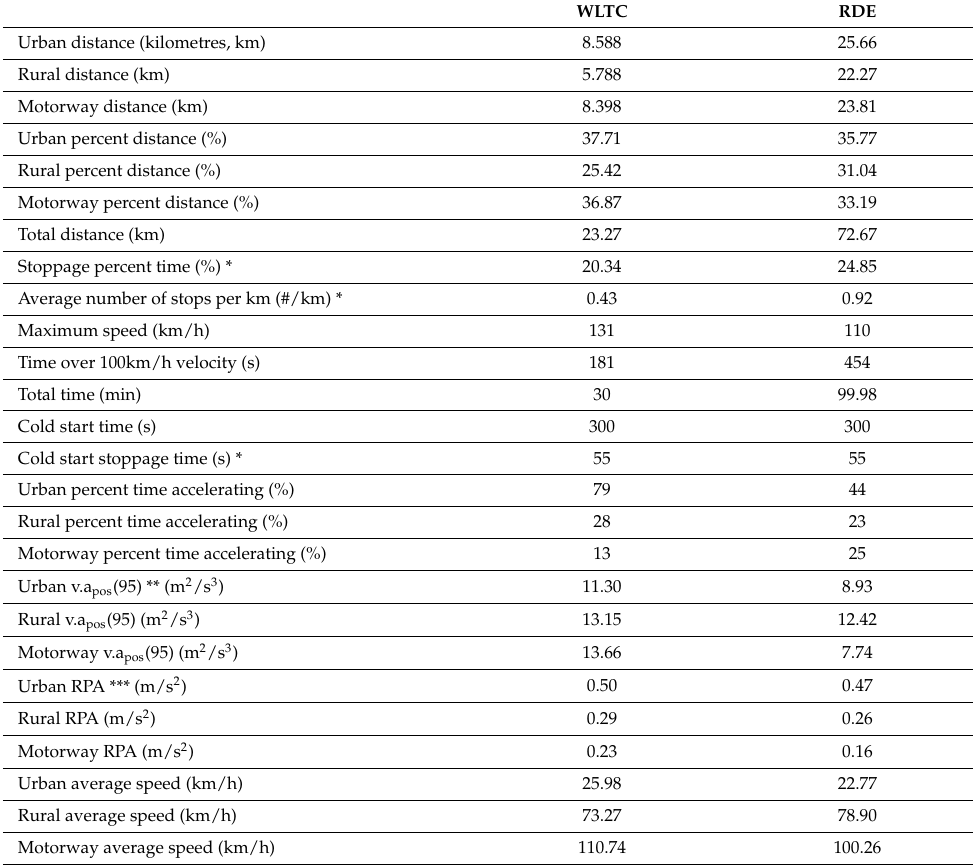
Table 2. Properties of the WLTC and RDE-style